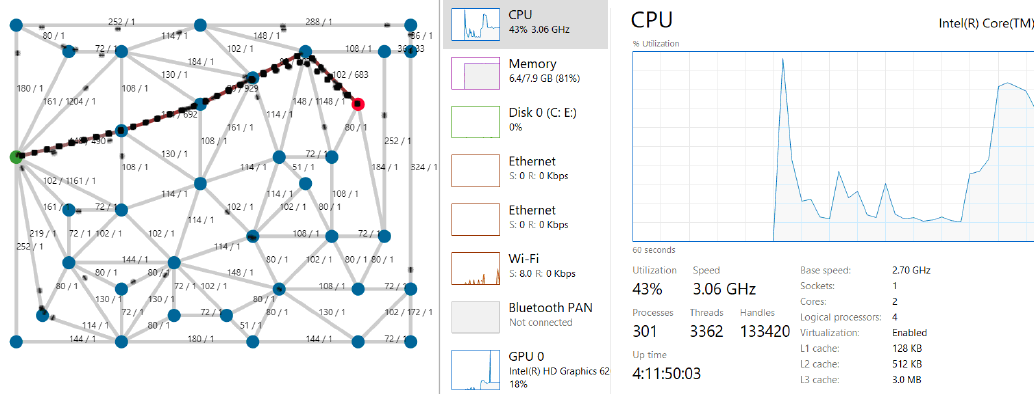
Figure 47: Presentation of paper